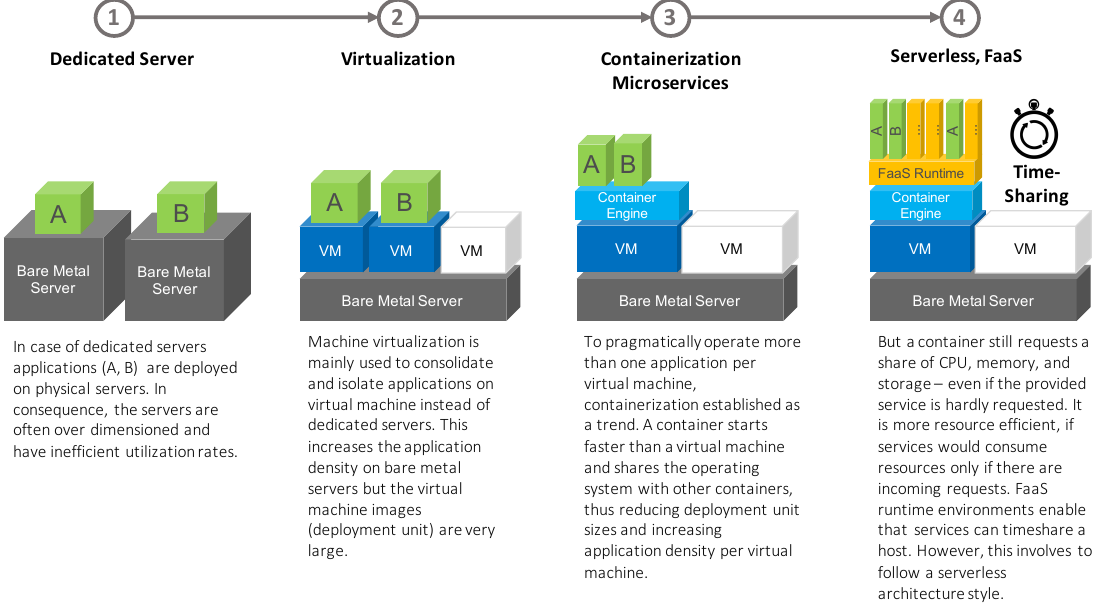
Figure 7. Observable trend of minimizing deployment unit sizes, taken from